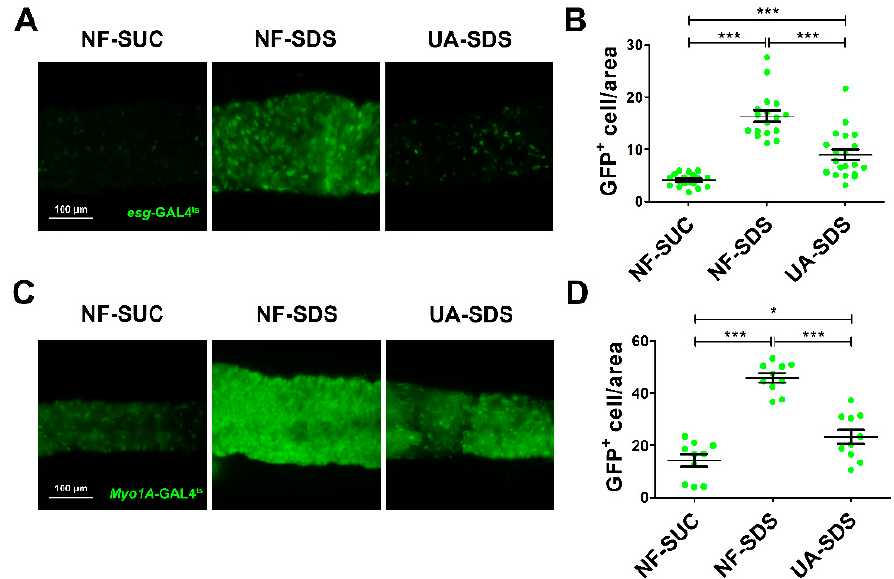
Figure 3. UA protected intestine from SDS-induced intestinal stem cell (ISC) proliferation and differentiation. ( A ) UA could significantly reduce proliferation and differentiation of ISCs/ enteroblasts (EBs). ( B ) Fluorescence intensity of the GFP + ISCs/EBs in panels (n ≥ 15). ( C ) UA could strongly decrease SDS-induced EC proliferation. ( D ) Fluorescence intensity of the GFP + EC cells in panels (n ≥ 10). * p < 0.05, *** p < 0.001.